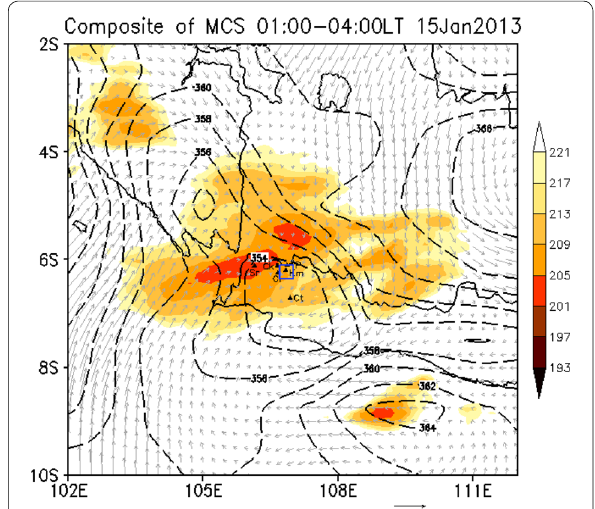
Fig. 8 Horizontal distribution of TBB composite (K, shaded), surface wind vector perturbation (m s − 1 , vector), and surface equivalent potential temperature (K, contour). For the first MCS TBB composite period 01:00–04:00 LT 15 January 2013, while surface wind vector perturbation and surface equivalent potential temperature at 01:00 LT 15 January 2013. The blue rectangle denotes the study area (106.7°E–107.0°E and 6.10°S–6.35°S)